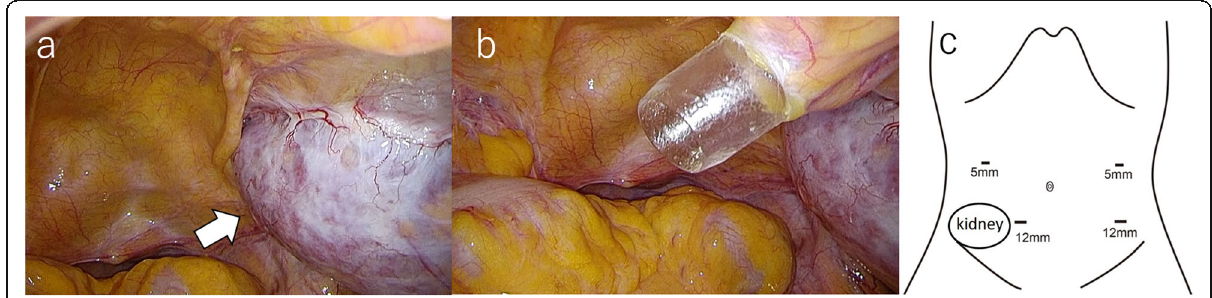
Fig. 4 The transplanted kidney was located in the right lower abdomen ( a , arrow). The right lower quadrant port was inserted more towards the midline than usual to avoid the transplanted kidney ( b , c